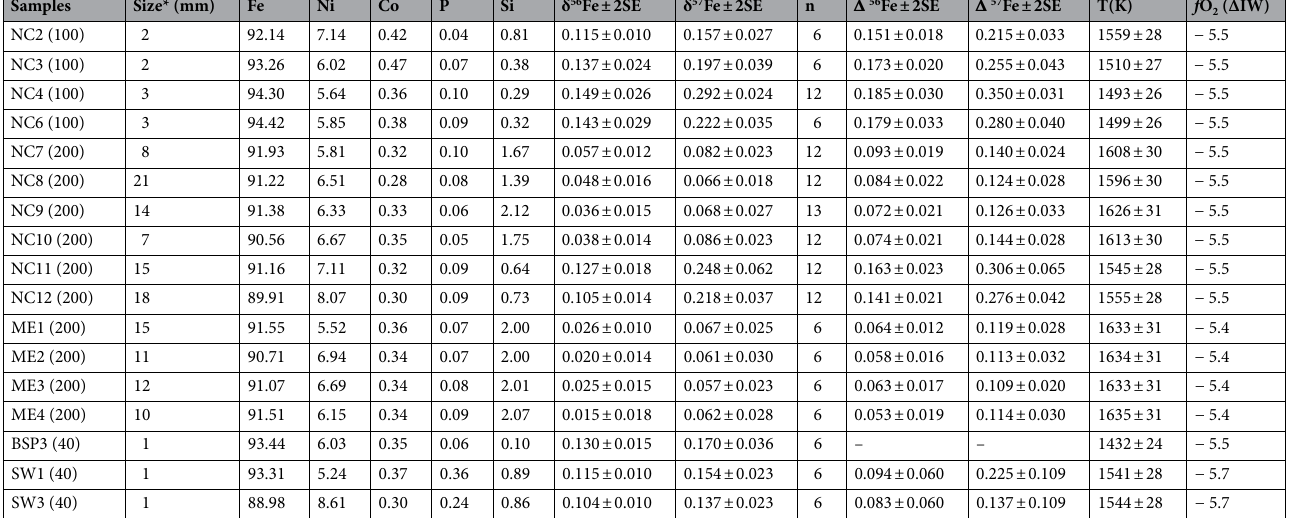
Table 1. Elemental and Fe isotope compositions of the metal grains from the Norton County (NC), Mount Egerton (ME), Bishopville (BSP), and Shallowater (SW) aubrites. Elemental concentrations are in wt% and are obtained by electron probe microanalysis (EPMA). Numbers within parentheses indicate number of EPMA data points averaged to obtain the elemental abundances of Fe, Ni, Co, P, and Si for each nodule. The (cid:31) 56 Fe 56 Fe 13, 17 of δ 56 Fe metal-silicate values are calculated using the δ metal from this study and published values silicate for that particular meteorite; (cid:31) 57 Fe metal-silicate is calculated similarly (note that δ 56 Fe silicate and δ 57 Fe silicate for BSP do not exist, so (cid:31) 56 Fe and (cid:31) 57 Fe for this aubrite are not calculated). Calculated equilibration temperature (T in